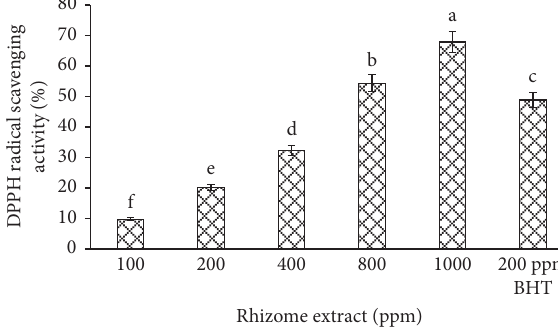
Figure 3: Scavenging activity of free radicals by different con- centrations of the methanolic extract of C. dactylon rhizomes in comparison with the synthetic antioxidant BHT (different letters indicate statistically significant differences between groups as de- termined by the Duncan test ( p < 0 .